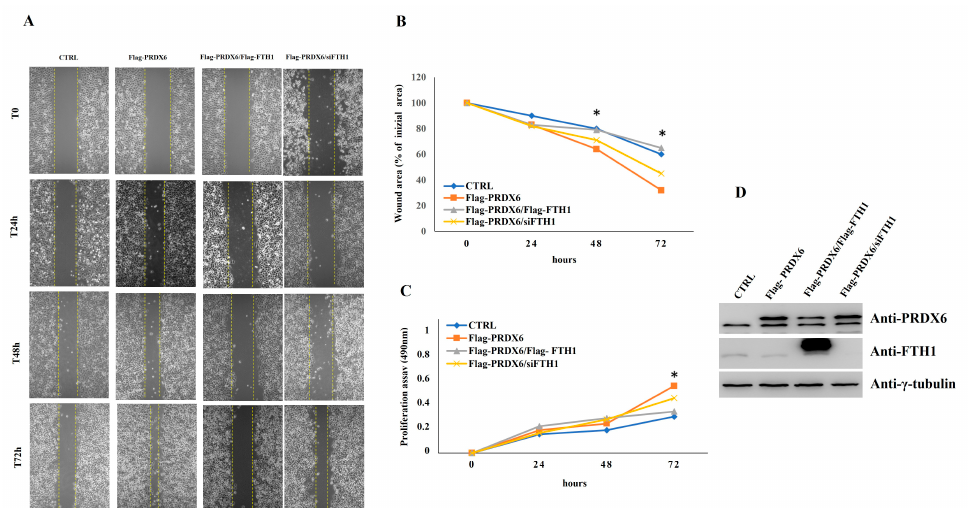
Figure 6. Scratch wound healing and MTT proliferation assays. ( A ) After transfection with control vector, (3xFlag) Flag-PRDX6, Flag-PRDX6/Flag-FTH1 and Flag-PRDX6/siFTH1 confluent NCI-H460 cells monolayers were scratched to induce horizontal migration (magnification of 10×) at 0, 24, 48 and 72 h. ( B ) The wound areas were measured using Image J 1.42q software. The histogram indicates wound area/% of initial area. Value, represent mean ± SD; n = 3; p -value Flag-PRDX6_vs._3xFlag, Flag-PRDX6_vs._Flag-PRDX6/Flag-FTH1 and Flag-PRDX6_vs_Flag-PRDX6/siFTH1 is considered not statistically significant at 24 h. Flag-PRDX6_vs_3xFlag, Flag-PRDX6_vs_Flag-PRDX6/Flag-FTH1 is considered statistically significant at 48 and 72 h, p < 0.005; Flag-PRDX6_vs._Flag-PRDX6/siFTH1 is considered not statistically significant at 48 and 72 h. ( C ) NCI-H460 cells, transfected with control vector, Flag-PRDX6, Flag-PRDX6/Flag-FTH1, and Flag-PRDX6/siFTH1 seeded in 24 wells and were cultured for 0, 24, 48 and 72 h, and their proliferation was determined by absorbance at 490 nm. Final results represent mean ± SD of three independent experiments, each performed in triplicate. p -value Flag-PRDX6_vs._3xFlag, Flag-PRDX6_vs._Flag-PRDX6/Flag-FTH1 and Flag- PRDX6_vs._Flag-PRDX6/siFTH1 are considered not statistically significant at 24 and 48 h. Flag- PRDX6_vs._3xFlag p < 0.05 and Flag-PRDX6_vs_Flag-PRDX6/Flag-FTH1 p < 0.005 at 72 h; Flag- PRDX6_vs._Flag-PRDX6/siFTH1 is considered not statistically significant at 72 h. ( D ) Western Blot analysis was performed to confirm PRDX6 and PRDX6/FTH1 overexpression and siFTH1 silencing. γ -tubulin was used as a loading control.